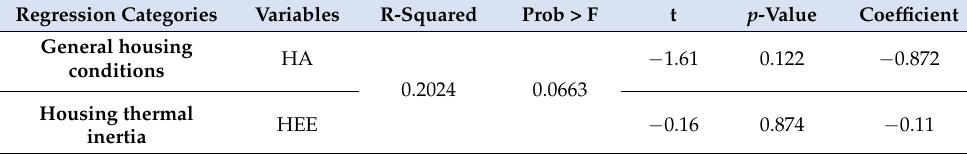
Table 7. Regression analysis results: heat-related mortality rate (MOR).